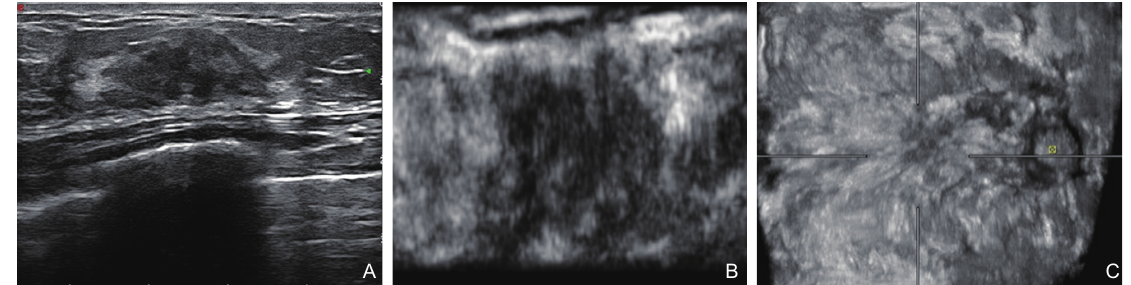
Figure 1 A 33-year old woman with invasive ductal carcinoma in the right breast. (A) Conventional ultrasound showed a hypoechoic lesion (11.2 × 10.1mm) with an oval shape and indistinct margin, and the final category was BI-RADS 4B for US; (B) Based on the findings in 3D-US imagings, the final BI-RADS category was BI-RADS 4B; (C) ABVS images showed the retraction phenomenon in the coronal plane, the final category was increased to BI- RADS 4C. BI-RADS, breast imaging reporting and data system; US, ultrasound; 3D-US, three-dimensional US; ABVS, automated breast volume scanner.